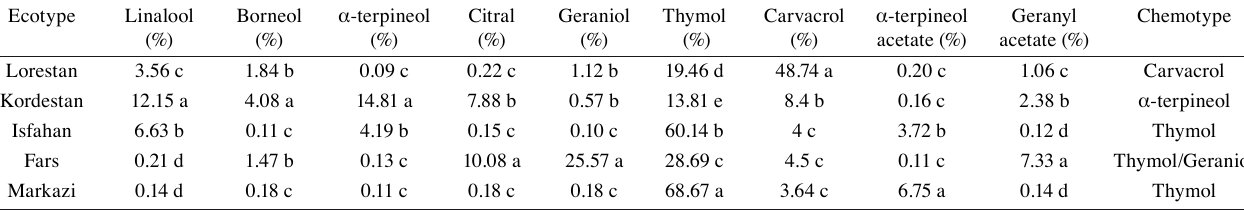
Tab. 8: Major constitutes in essential oil of different ecotype of T. lancifolius